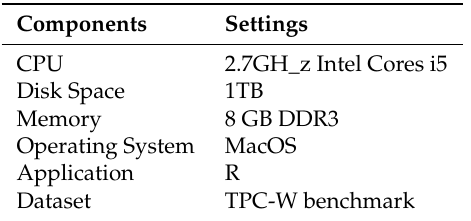
Table 2. Hardware and software specification used in the experiment.